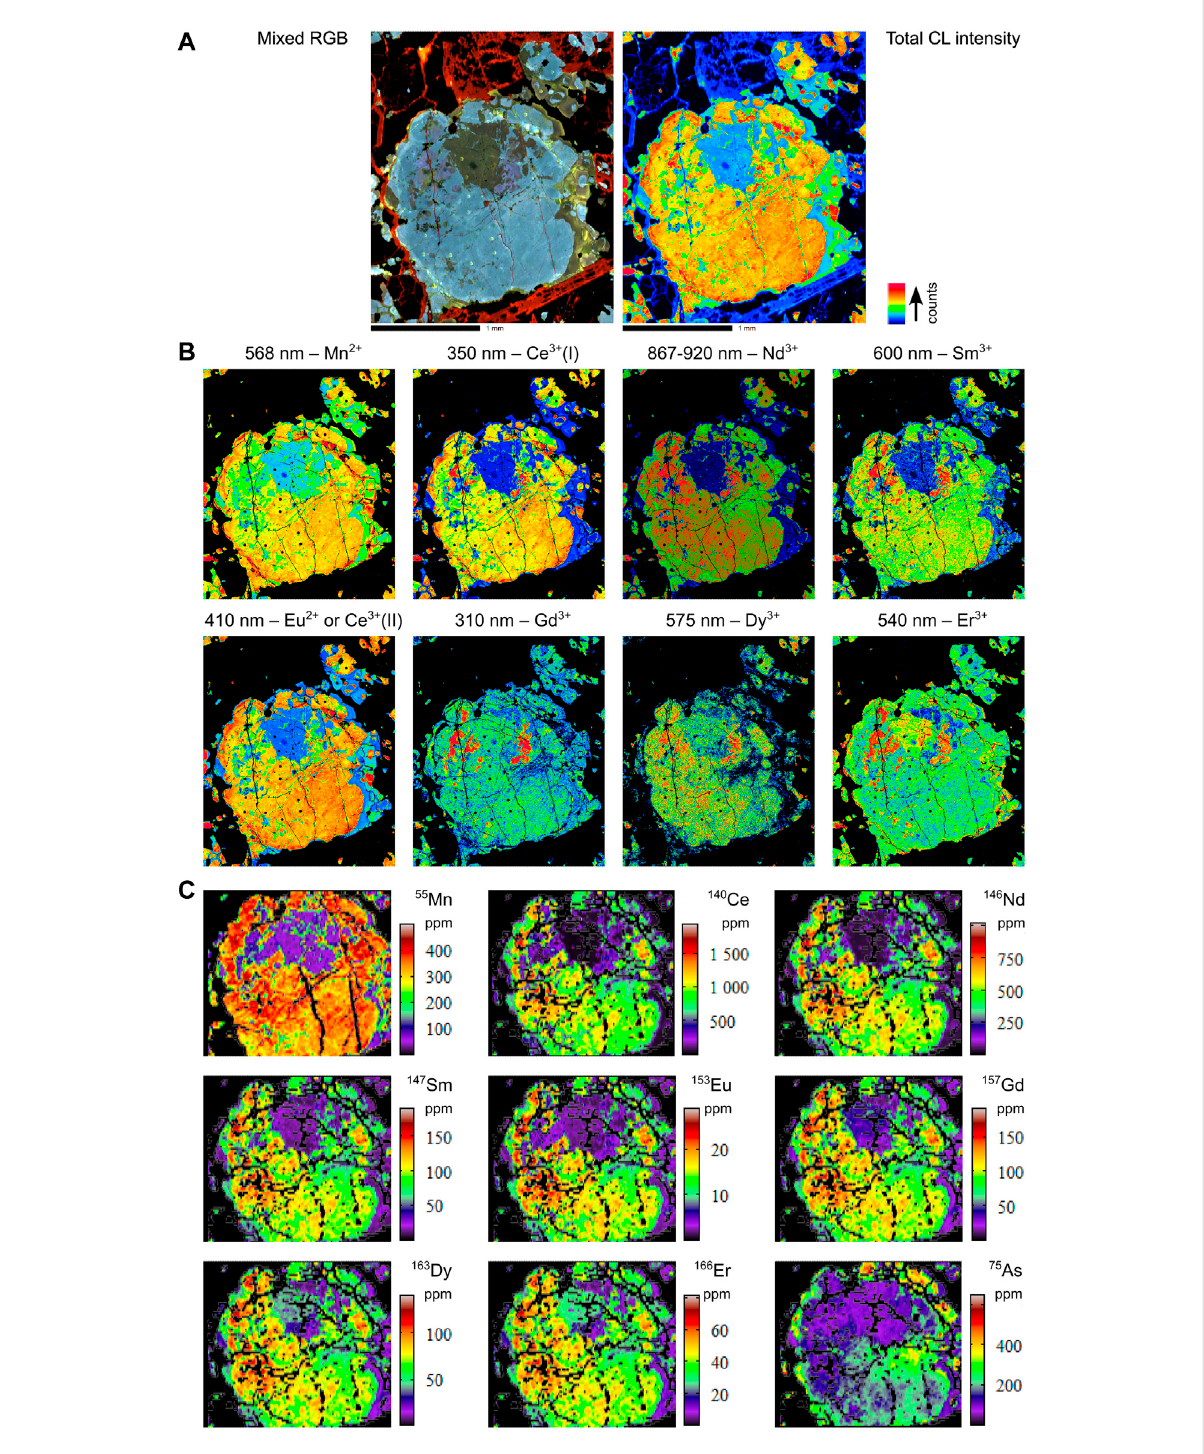
FIGURE 6 Combined hyperspectral CL and LA-ICPMS images of selected elements for sample MMA2-122.75. (A) Total CL intensity and mixed RGB images. (B) Hyperspectral CL images. (C) LA-ICPMS images.